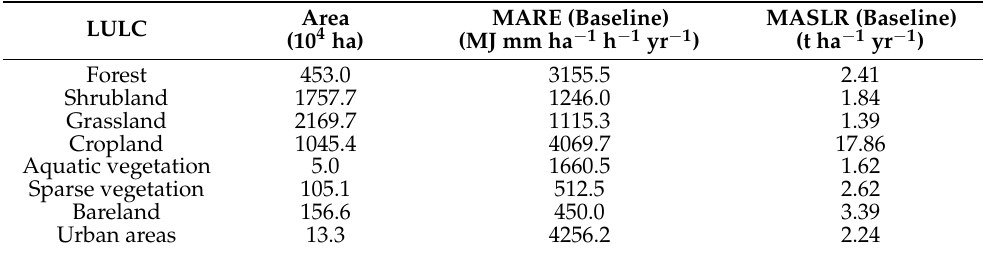
Table 5. Baseline soil erosion rates per LULC in Kenya.